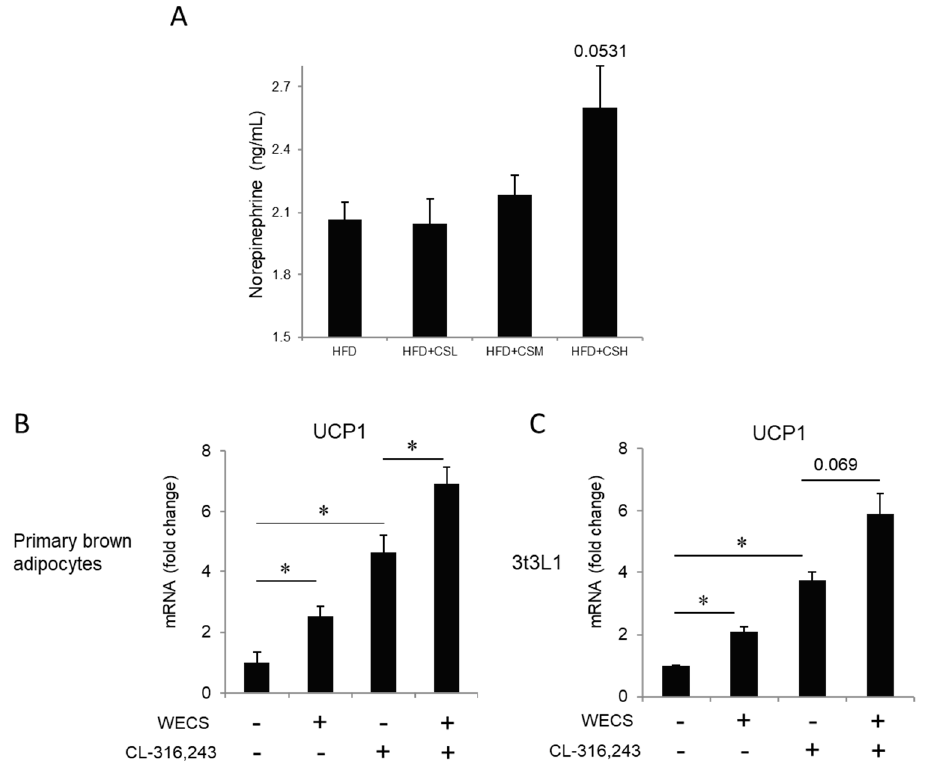
Figure 4. The effect of WECS on the sympathetic pathway. The concentration of norepinephrine in serum ( A ). The effect of WECS and β 3 adrenergic agonist (CL ‐ 316,243) in brown adipocytes and 3T3L1 after browning induction ( B and C ). Bars represent the mean + SEM, n = 3–5. * p < 0.05.